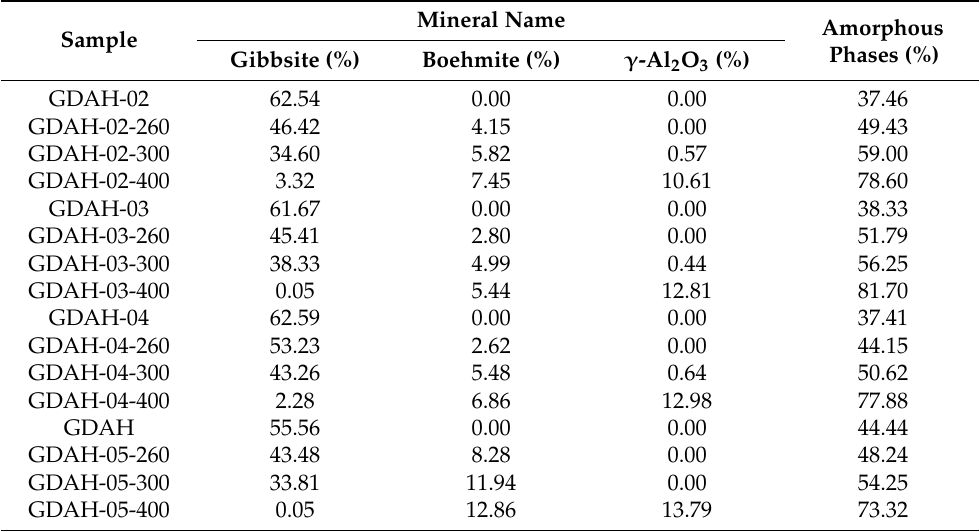
Table 2. Effect of the calcination temperature on the phase composition and amorphous